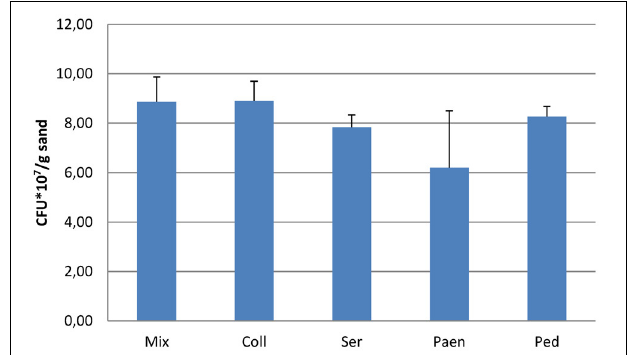
FIGURE 1 | Number of bacteria (CFUs) after 3 days of incubation in sand containing artificial root exudates. Coll- Collimonas pratensis Ter 91; Ser- Serratia plymuthica PRI-2C; Paen- Paenibacillus sp. P4; Ped- Pedobacter sp. V48 and Mix- mix of all four bacteria. Inoculation densities were 3 . 0 × 10 6 /gr sand. Presented values are means of three replicates and error bars indicate standard deviation. No significant differences were found between the different bacterial